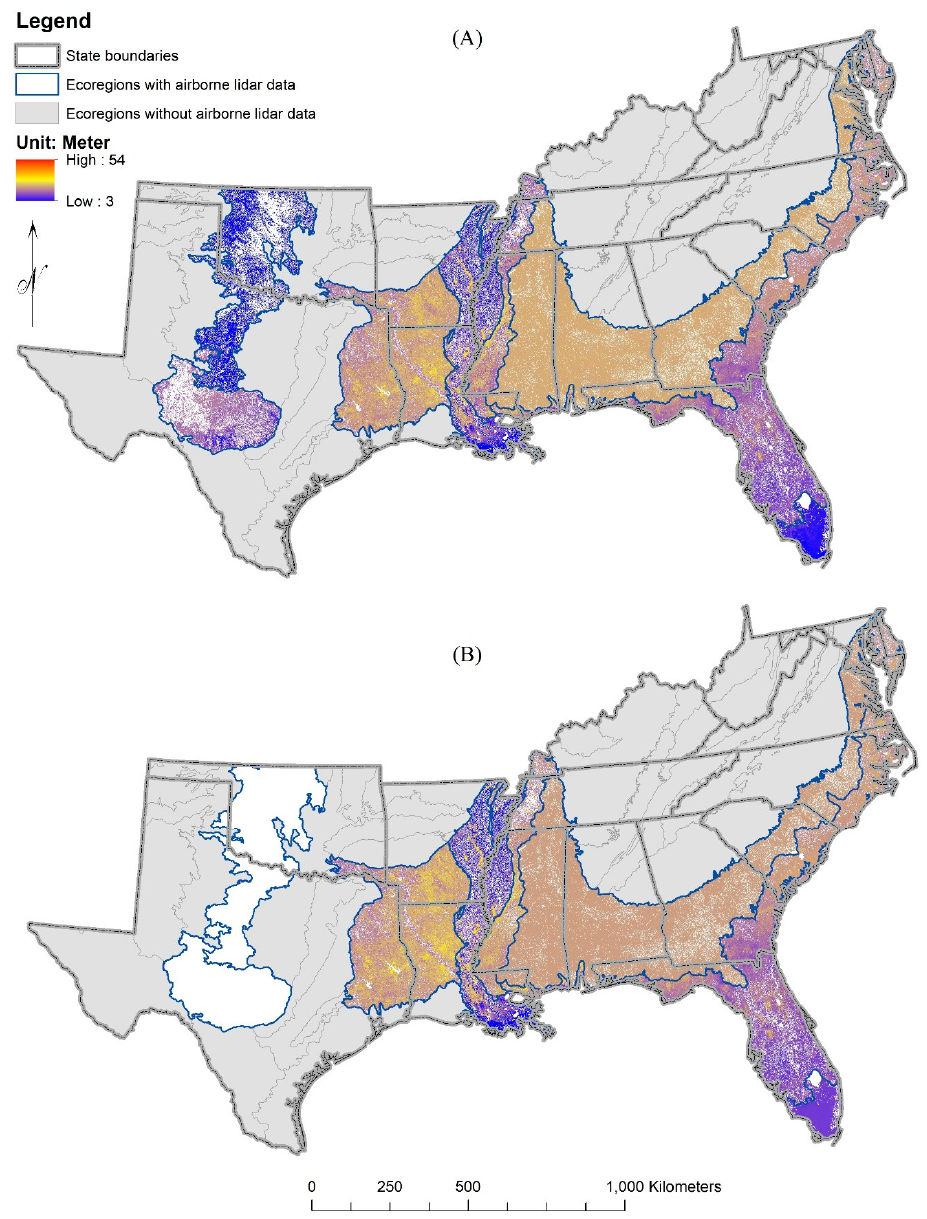
Figure 9. The recalibrated GCHMs by each ecoregion: ( A ) recalibrated GCHMs of each ecoregion by 90th percentile heights at 0 m height category with 80% data and ( B ) 20% data.